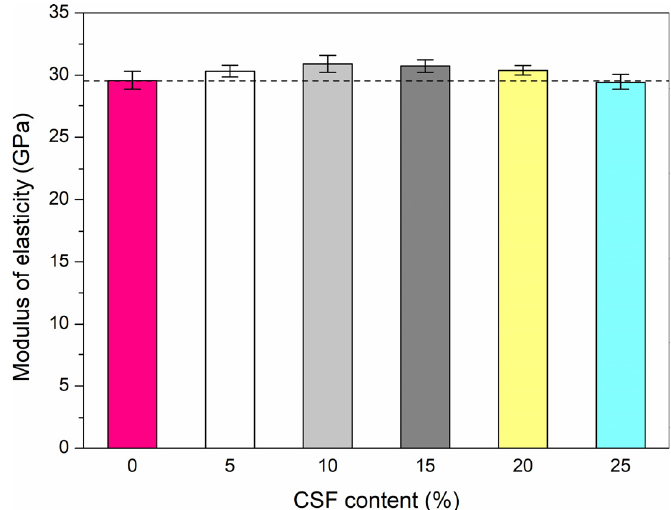
Figure 5. Variation of the elastic modulus with CSF replacement.